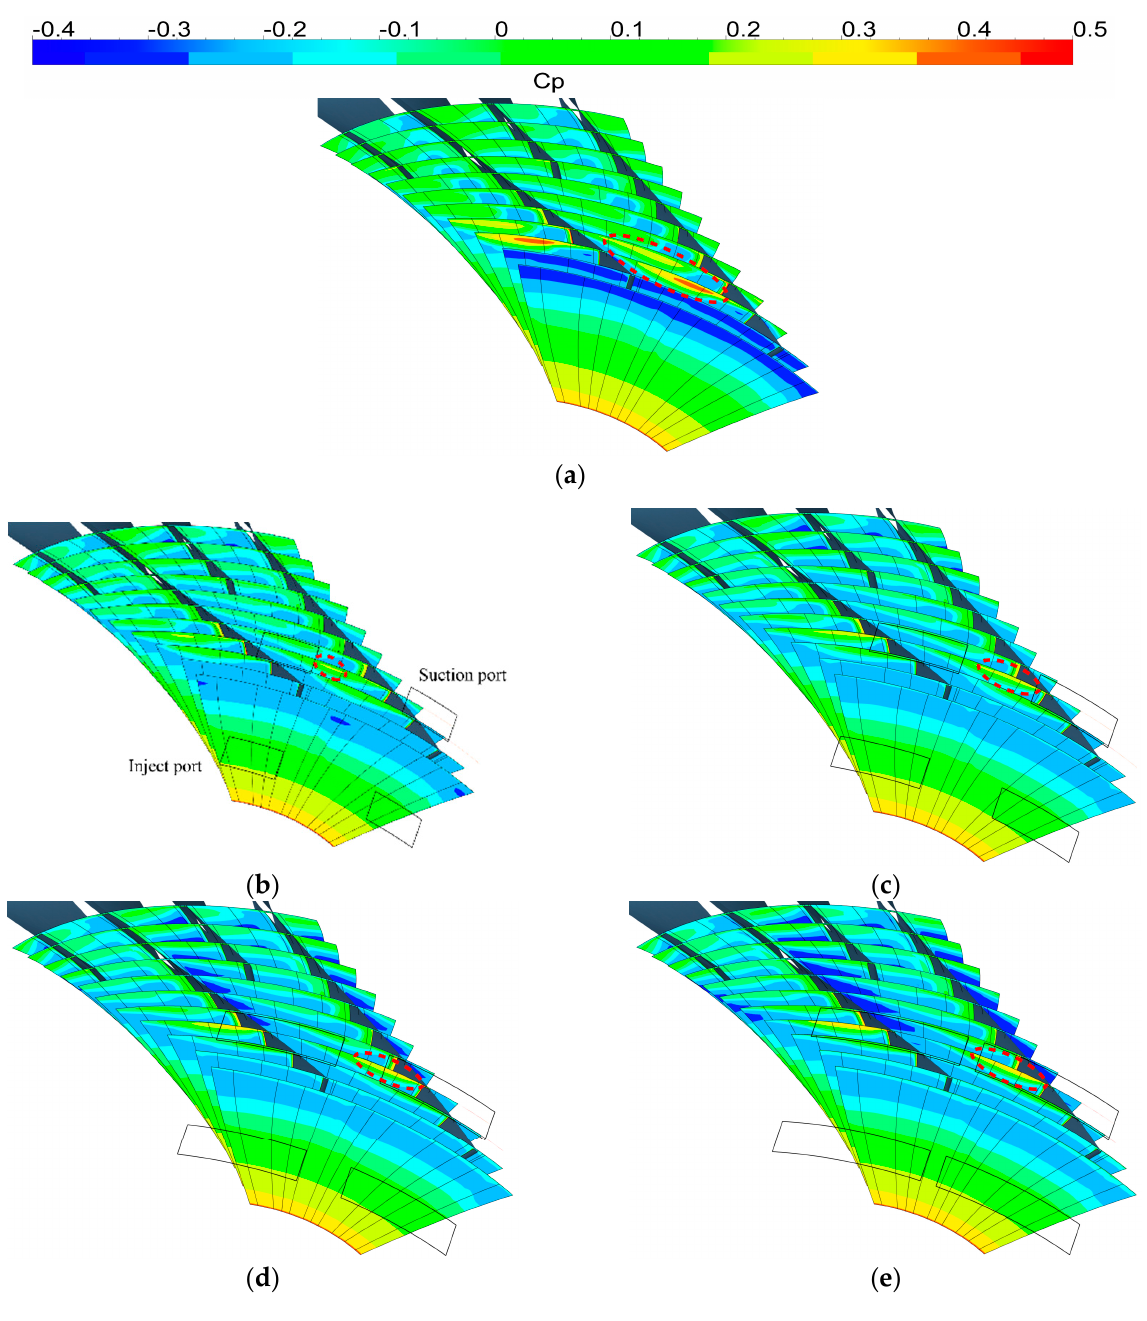
Figure 27. Contours of total pressure loss coefficient at the blade tip under different self-circulating casings. ( a ) SW. ( b ) SRCC0.36. ( c ) SRCC0.54. ( d ) SRCC0.72. ( e ) SRCC0.9.